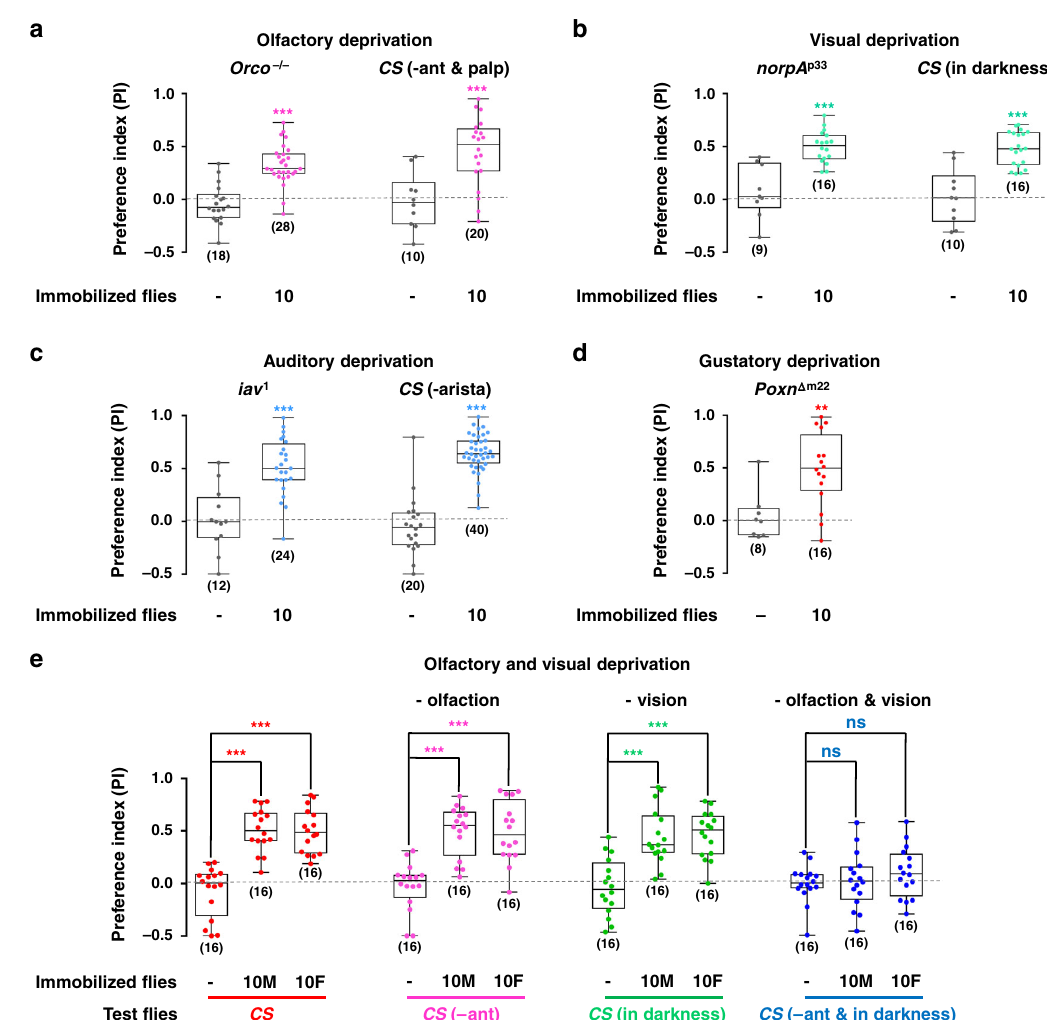
Fig. 2 Olfaction and vision mediate social attraction in Drosophila melanogaster . a – d Removing a single sensory modality was not suf fi cient to block social approach behaviour. a Deprivation of olfaction through using Orco mutants or Canton S lacking antennae (-ant) and maxillary palp (-palp). b Deprivation of vision through using norpA p33 mutants or testing Canton S in the dark. c Deprivation of auditory sense through using iav 1 mutant or Canton S without arista. d Deprivation of gustatory sense through Poxn Δ m22 mutants. e Simultaneously removing the olfactory and visual sense, by testing Canton S lacking antennae (-ant) in the dark, eliminated social approach behaviour. n = 16. Results are presented as a box and whisker plot; whiskers indicate the minimum and maximum, the box includes the 25th – 75th percentile, and the line in the box indicates the median of the data set. Statistical analysis: t-test for two group only comparisons ( a – d ) and one-way ANOVA followed by Dunnett ’ s test for multiple comparisons ( e ). ns: P > 0.05, ** P < 0.01, *** P